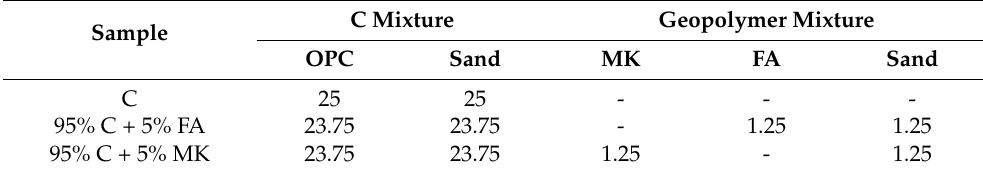
Table 2. Designation of samples depending on the used mix proportions per 50 kg of